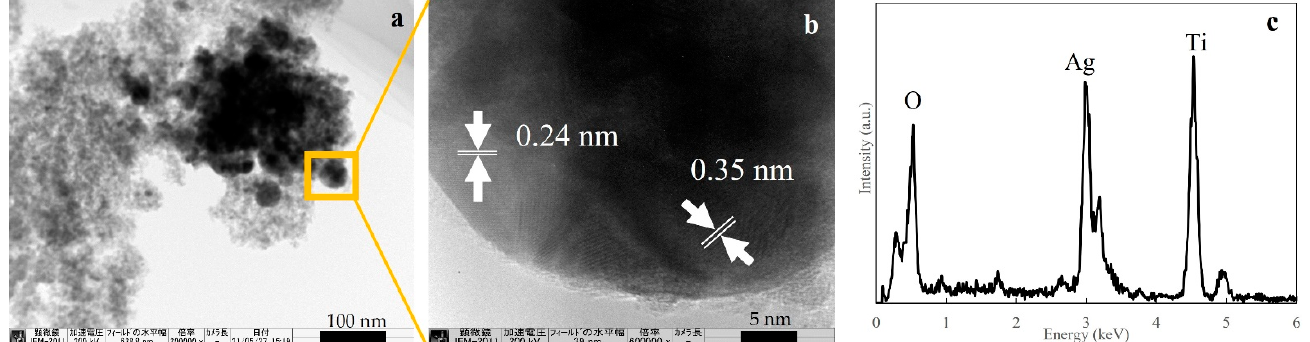
Figure 5. Structure and component of the TiO 2 –Ag (1 wt%) film: ( a ) transmission electron microscopy (TEM) image, ( b ) high-resolution TEM images, and ( c ) the corresponding energy dispersive X-ray profile of the region in the yellow square .